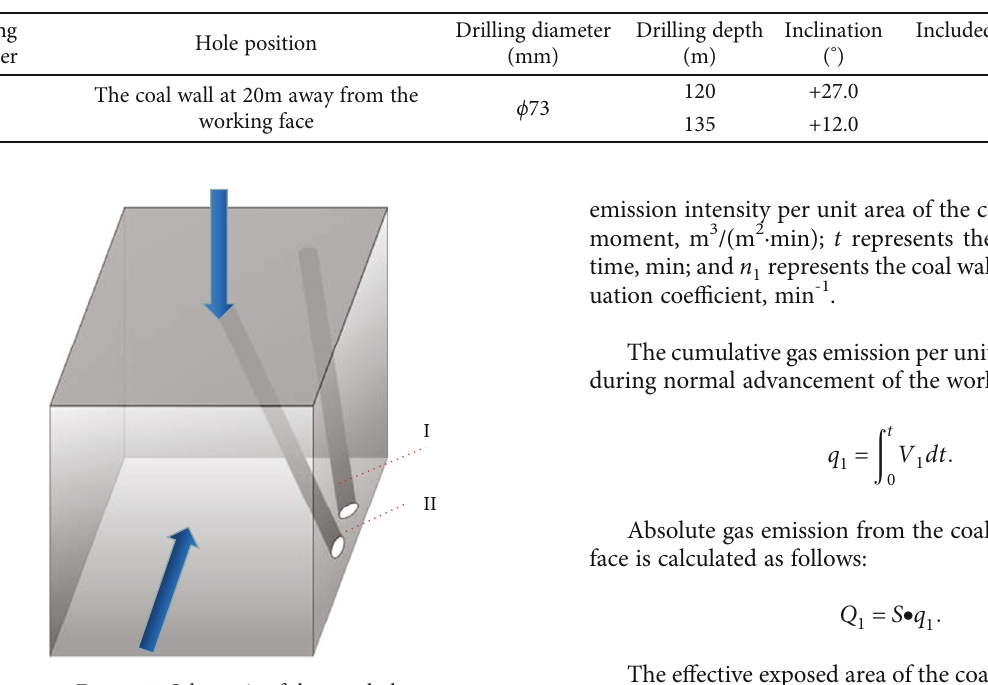
Table 1: Drilling parameters.